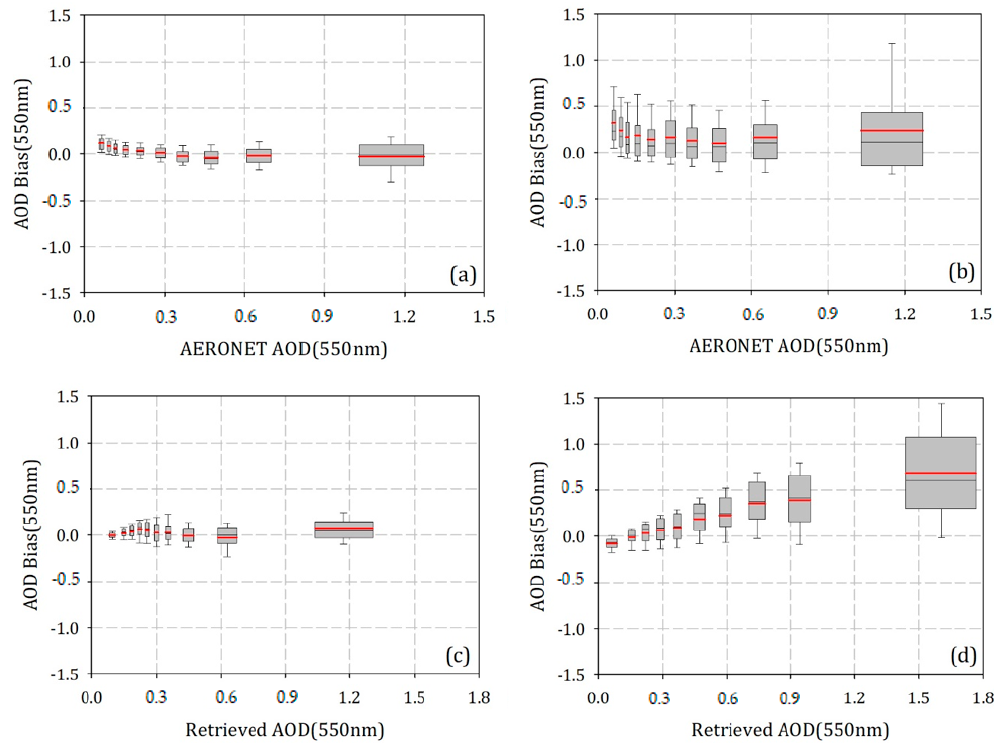
Figure 7. Bias between satellite-retrieved and AERONET AOD, plotted against ( a , b ) AERONET AOD; ( c ) AOD-new; ( d ) JAXA AOD. (red line and vertical gray line represent the mean value and 1 standard deviation of each AOD bin, respectively).